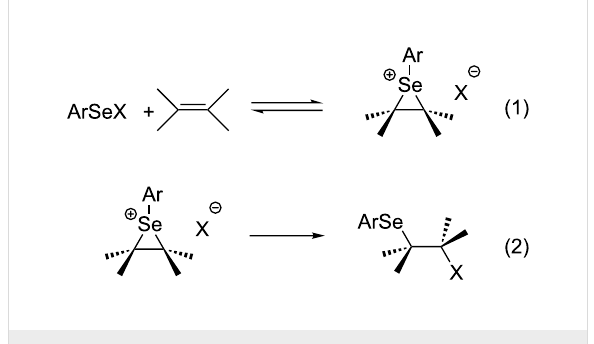
Scheme 1: Plausible mechanism of alkene